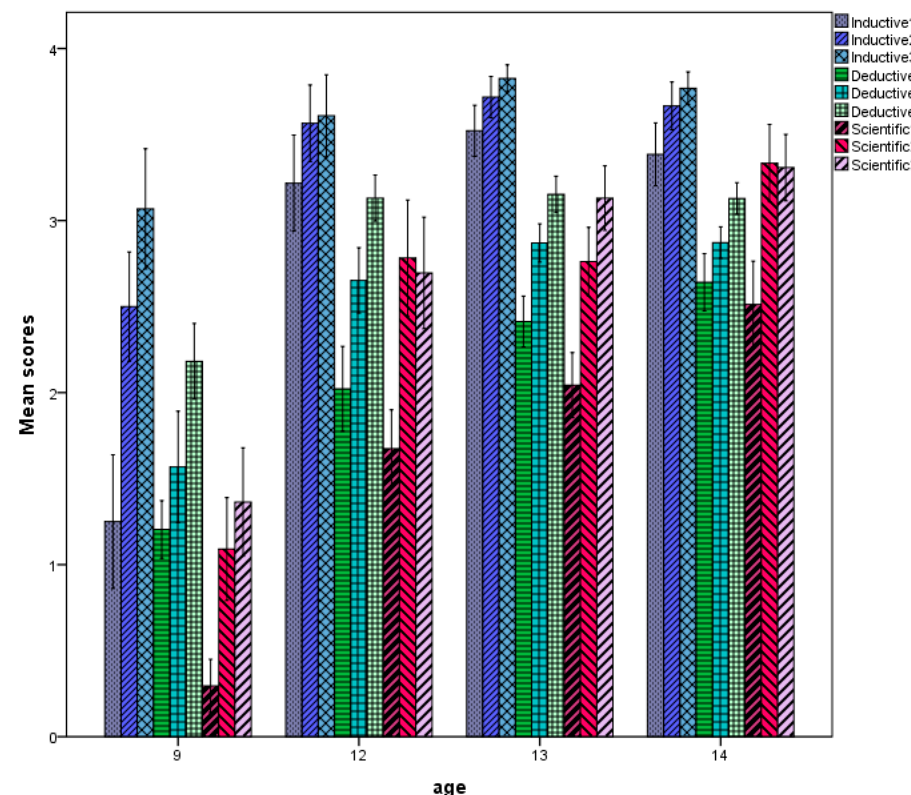
Figure 1. Performance on the three cognitive batteries across age and testing waves.